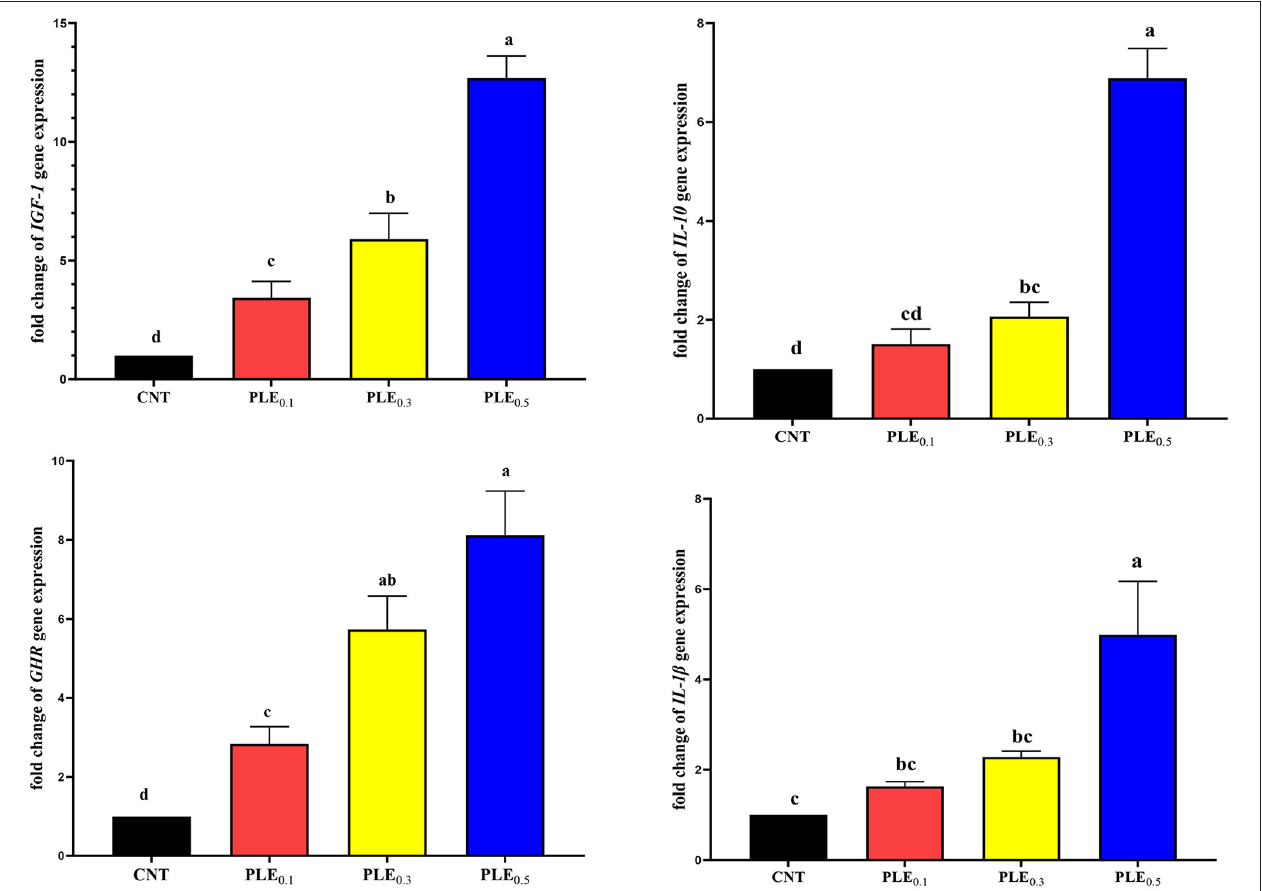
FIGURE 1 | The effect of PLE dietary supplementation on the mRNA expression of the broiler chicken hepatic ( IGF-1 and GHR ) and splenic ( IL-1 β and IL-10 ) genes (mean ± MSE). Columns with different superscript letters are significantly different ( P <